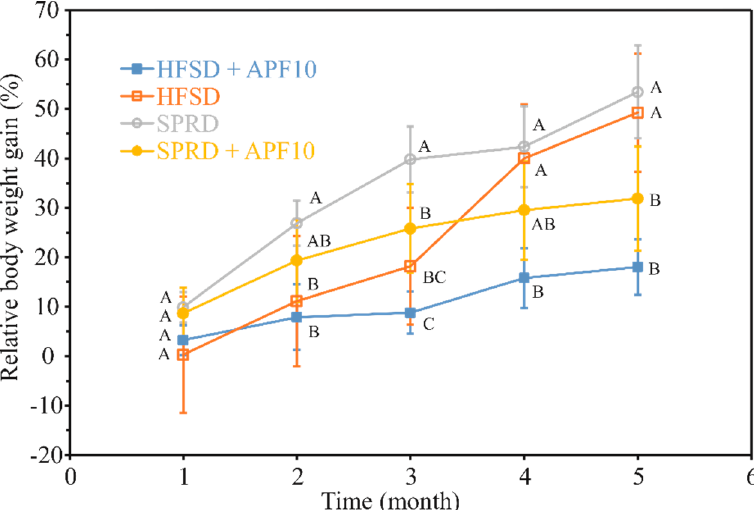
Figure 2. Relative body weight gain during 5 months exposure of mice to HFSD and SPRD with and without APF addition. Data were subjected to two-way repeated-measures ANOVA (between-subjects factor: feed treatment ( n = 8); four levels: HFSD, HFSD + APF, SPRD and SPRD + APF, degree of freedom was 3, F = 9.8 and p < 0.001; within-subject factor: time; five levels: 1, 2, 3, 4 and 5 months; degree of freedom was 4, F = 202.3 and p < 0.001; interaction “feed treatment × time”; degree of freedom was 12, F = 16.0 and p < 0.001); di ff erent uppercase letters within the same time indicate a significant di ff erence of means, according to Tukey’s HSD test ( p <